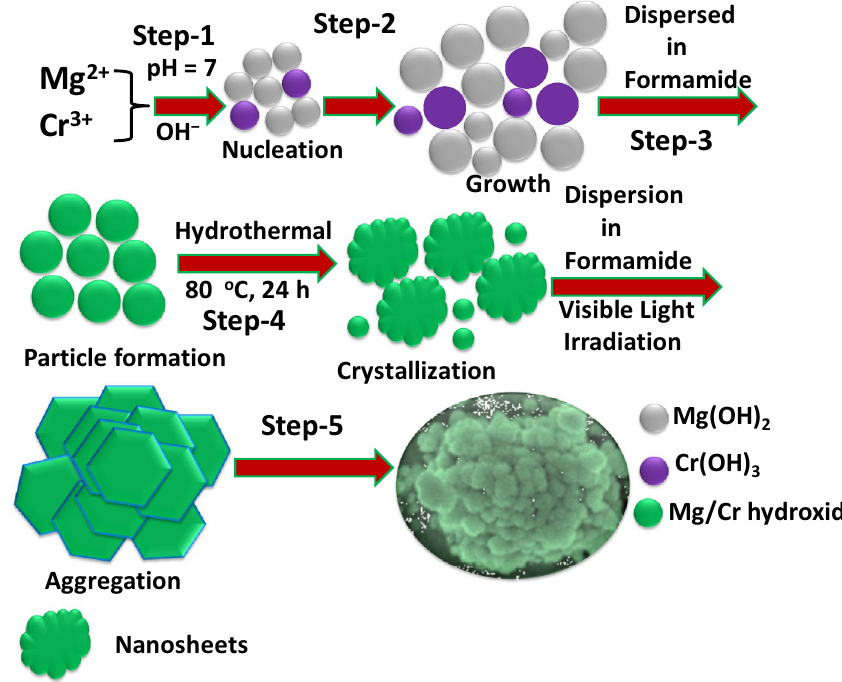
Figure 1. Growth mechanism of